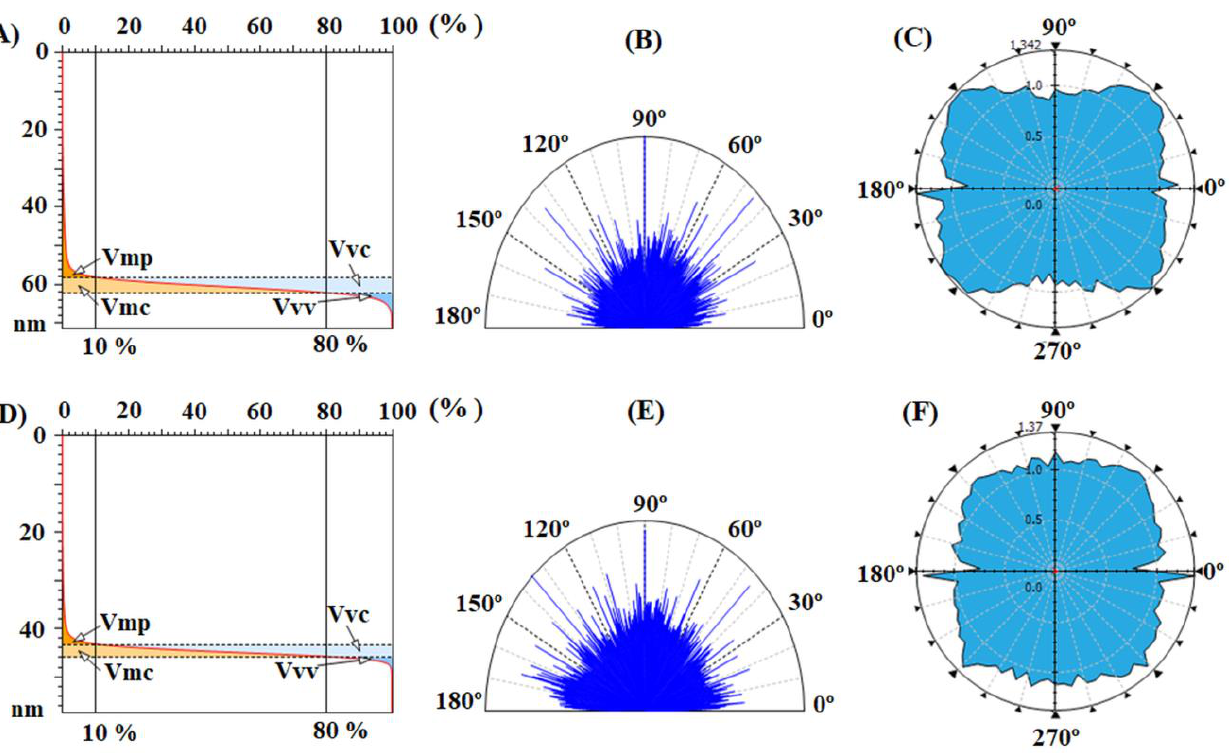
Figure 5. Abbott–Firestone curves with functional volume parameters, texture direction represen- tations and graphs with polar coordinates to analyze orientation with azimuth angle obtained for